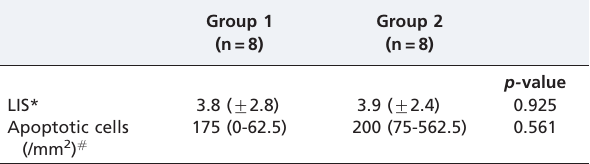
Table 2 - The histological features of the donor lungs.